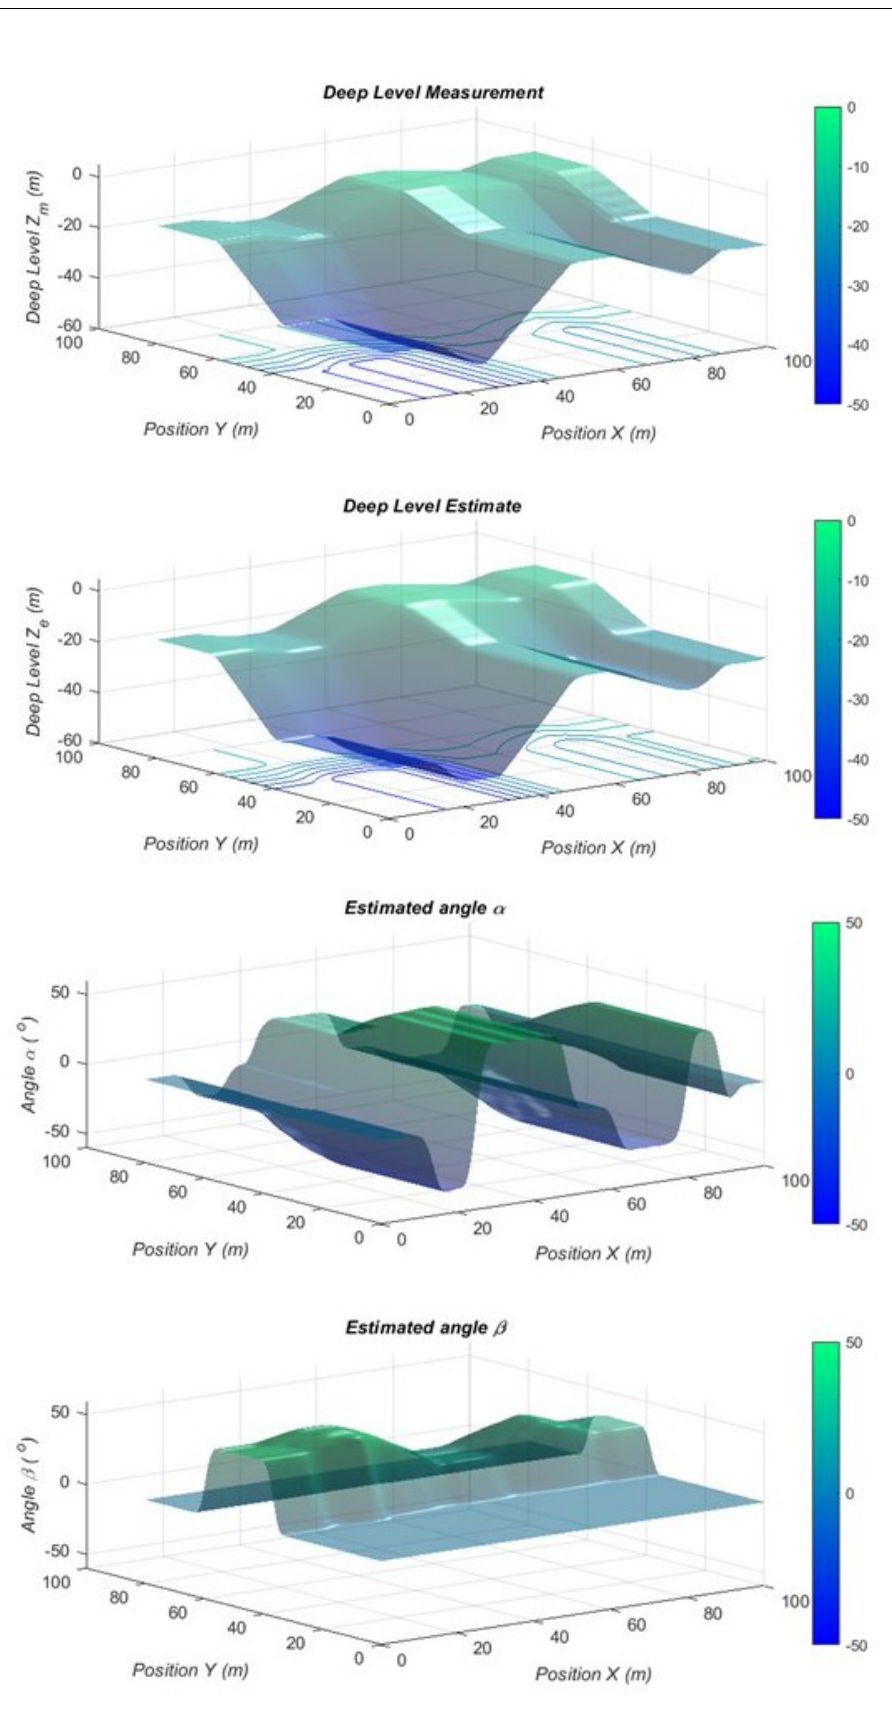
Figure 6. Underwater map with measured depth level and underwater map with estimated depth level. Estimated sea-bottom slope angles in the x ( α ) and y ( β )